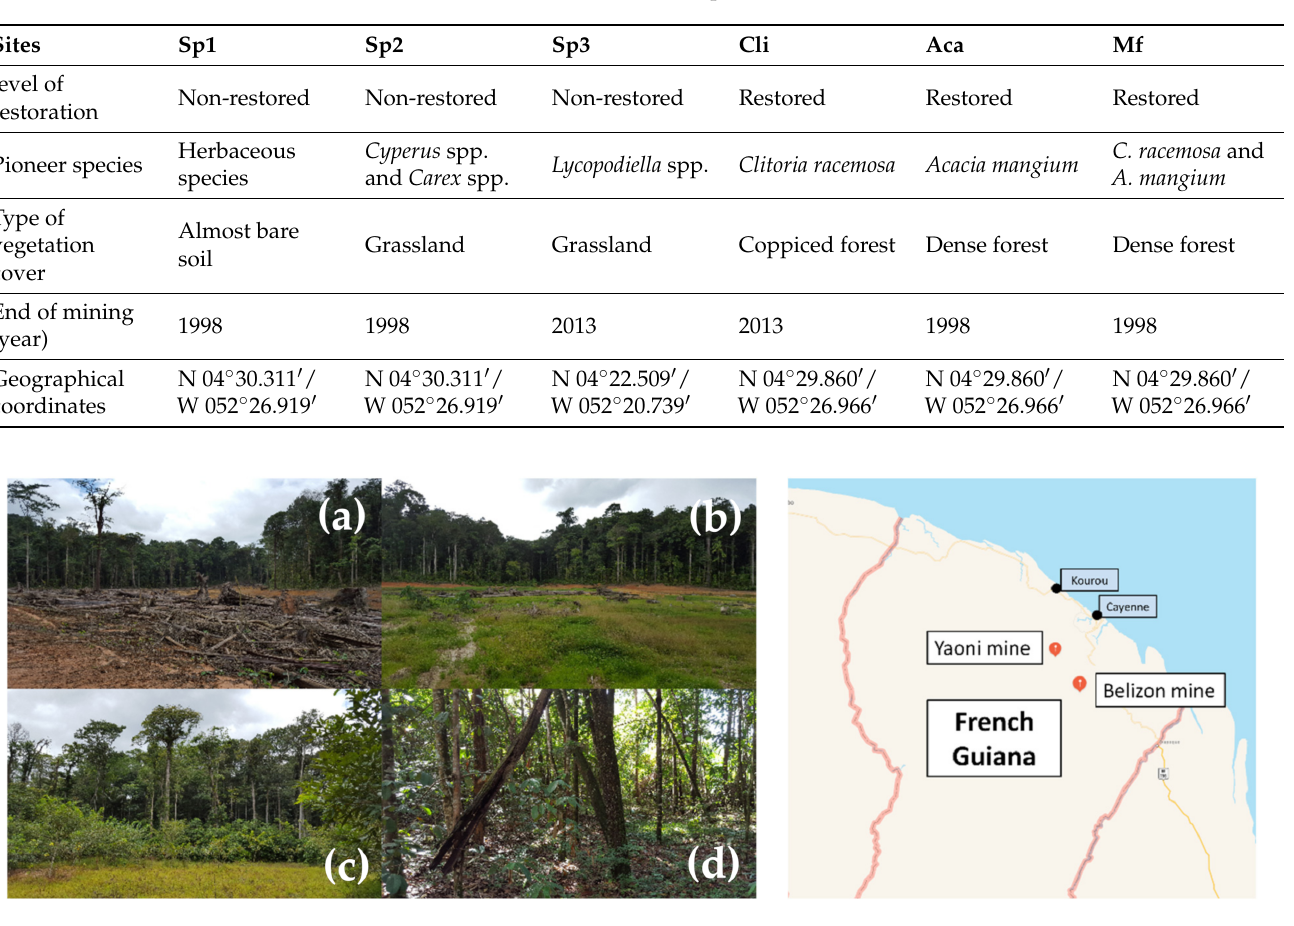
Figure 3. Illustration of some examples of different stages of ecological restoration on former Guyanese gold mining sites and geographical location of the Yaoni and Belizon mines in French Guiana. Non-restored site Sp1 ( a ), non-restored site Sp2 with herbaceous species after 3 years ( b ), ecological restoration with fabaceous species after 3 years (( c ), Cli), ecological restoration with faba- ceous species after 18 years (( d ), Mf). The pictures were taken during a second sampling campaign in April 2016 at sites undergoing ecological